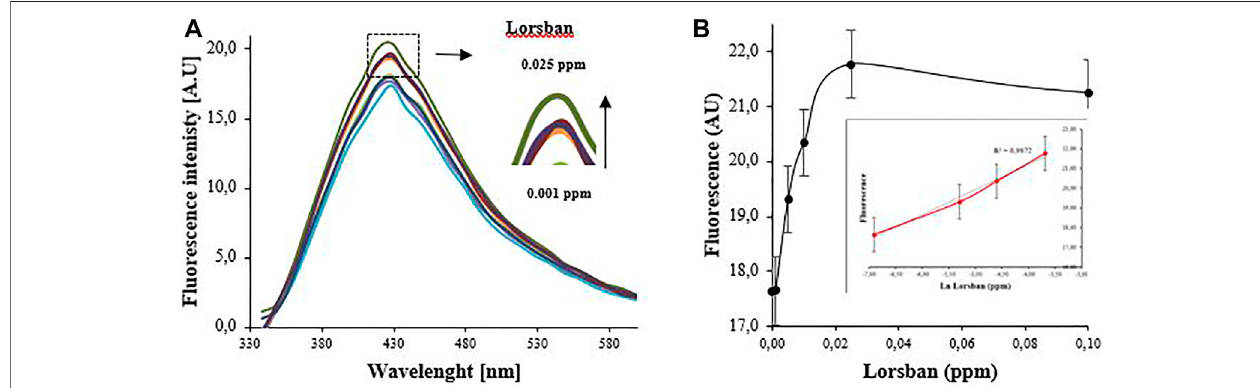
FIGURE 8 | Fluorescence response of the system in the presence of 0.1 ppm of different analytes in tap water. (A) Selectivity of the system for individual tests and (B) matrix effect of some mixes. The dotted line indicates the baseline (CD – AChE conjugate with GO). n = 6 independent experiments.